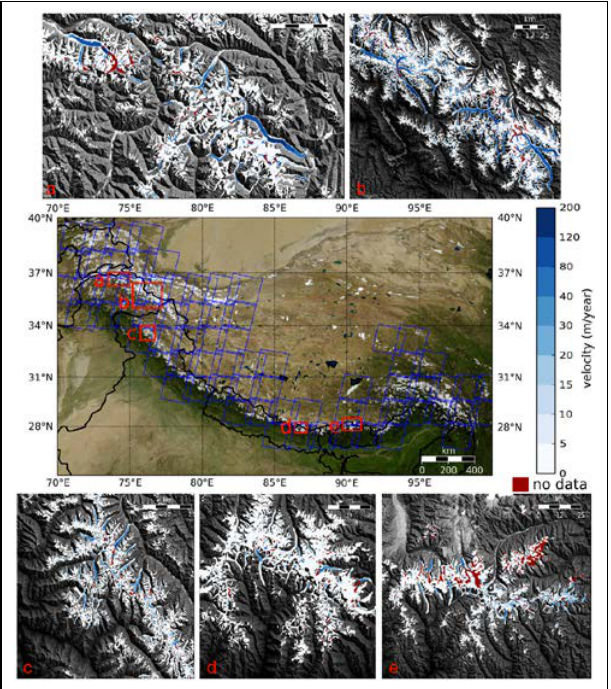
Figure 7. Surface flow velocity of glaciers in the